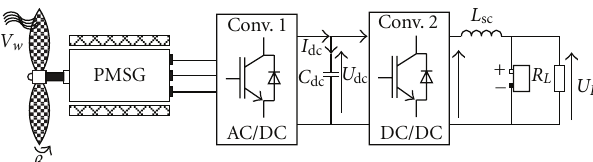
Figure 1: O ff -grid wind power generation system.